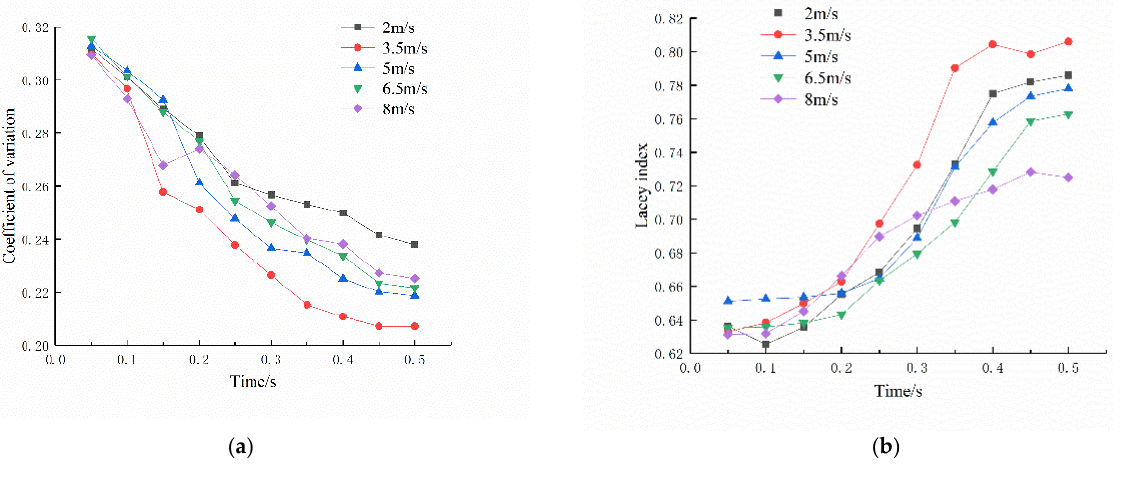
Figure 8. Effect of air velocity on particle-mixing uniformity. ( a ) Coefficient of variation of particles at different airflow velocities; ( b ) Lacey index of particles at different airflow velocities.